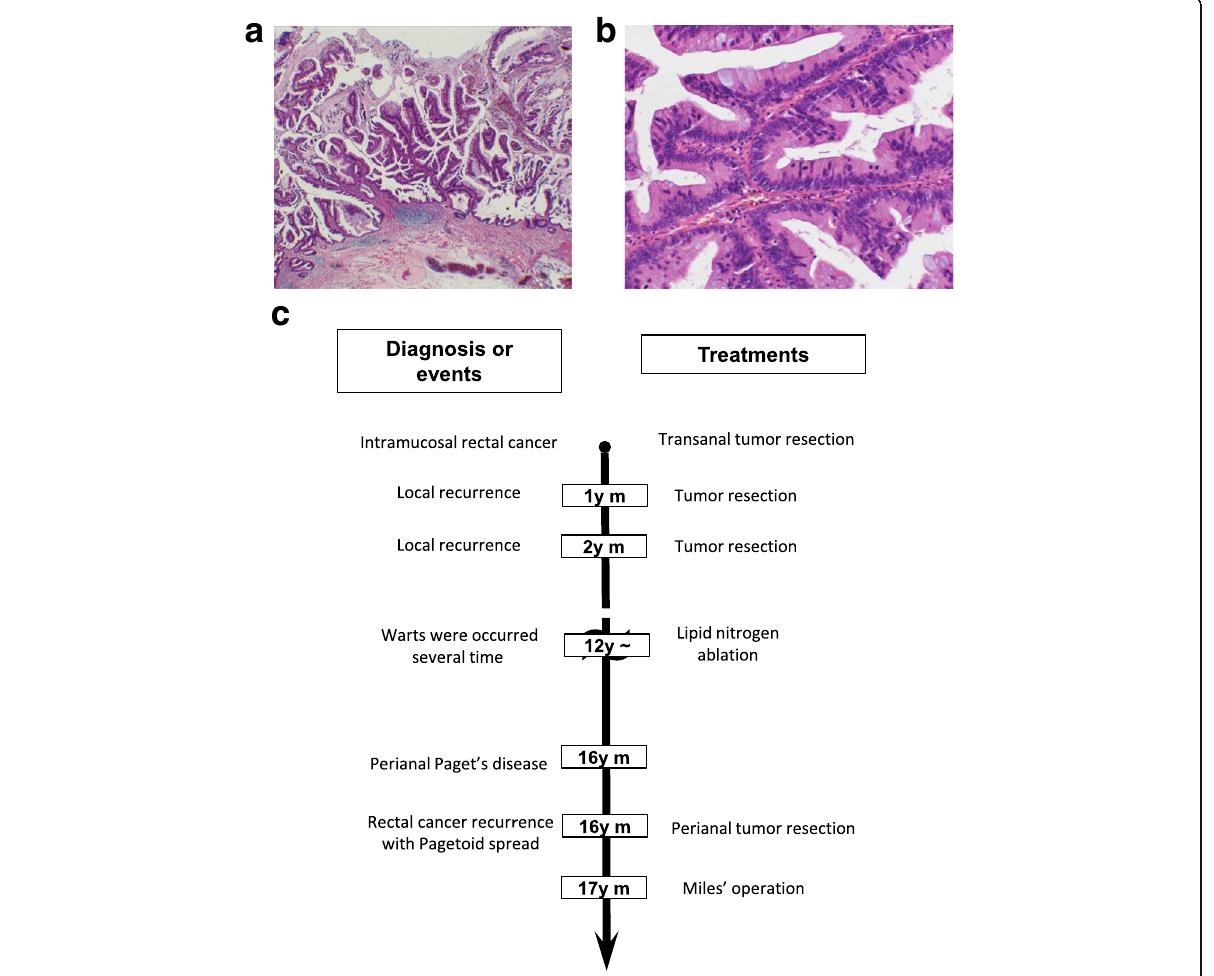
Fig. 1 The pathological features of specimen resected after the first operation. The tumor was seen in the intramucosal layer ( a ) (HE, ×20), which was well-differentiated adenocarcinoma ( b ) (HE, ×200). Schematic summary of the patient ’ s long-term clinical history. HE hematoxylin and eosin ( c